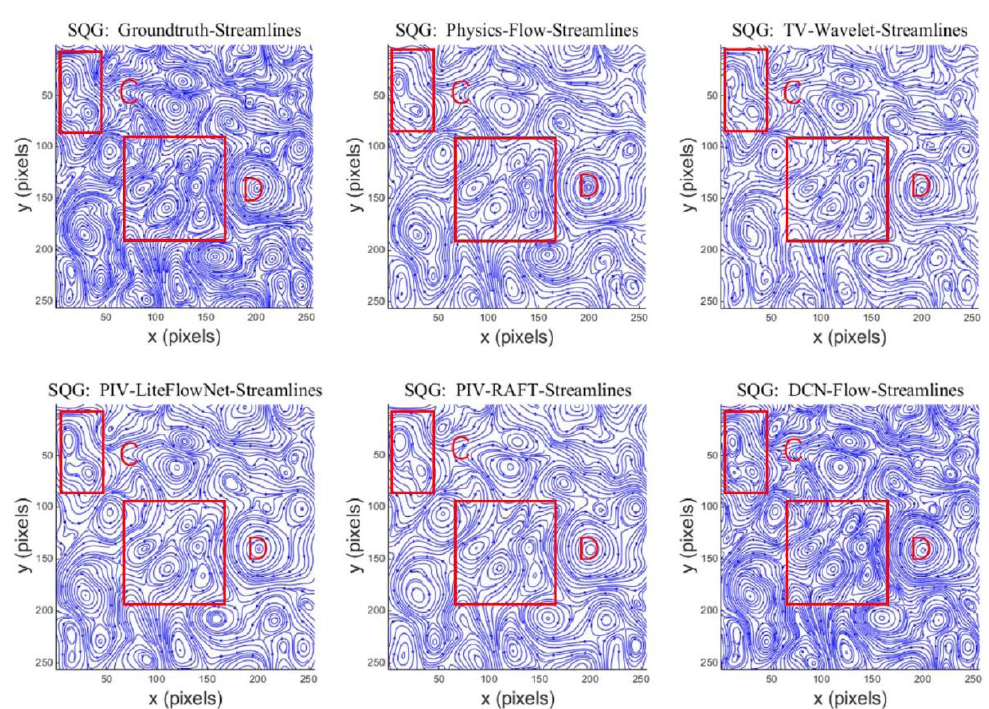
Figure 12. The streamlines of different motion estimators (Physics-Flow [38], TV-Wavelet Flow [39], PIV-LiteFlowNet [10], PIV-RAFT [11], and DCN-Flow) on an image pair from SQG flow.